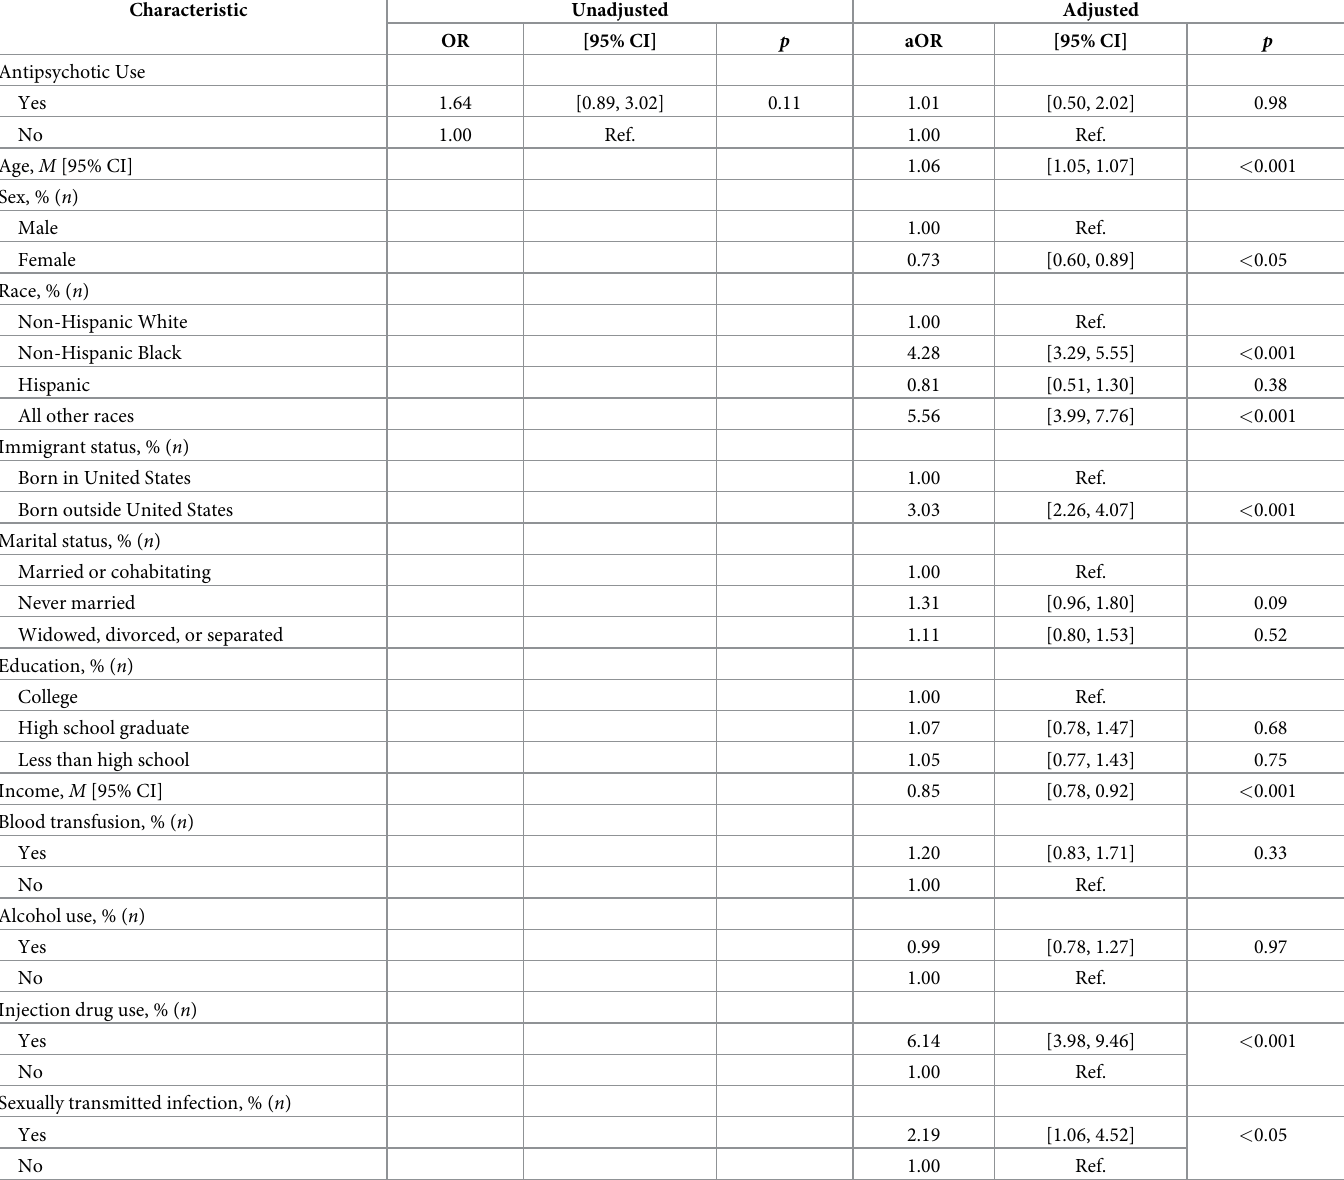
Table 2. Unadjusted and adjusted prevalence odds ratios, with 95% confidence intervals (CI), of the association between antipsychotic medication use and antibody to hepatitis B virus (HBV) among respondents to the 2005–2014 National Health and Nutrition Examination Survey ( n = 12,722).